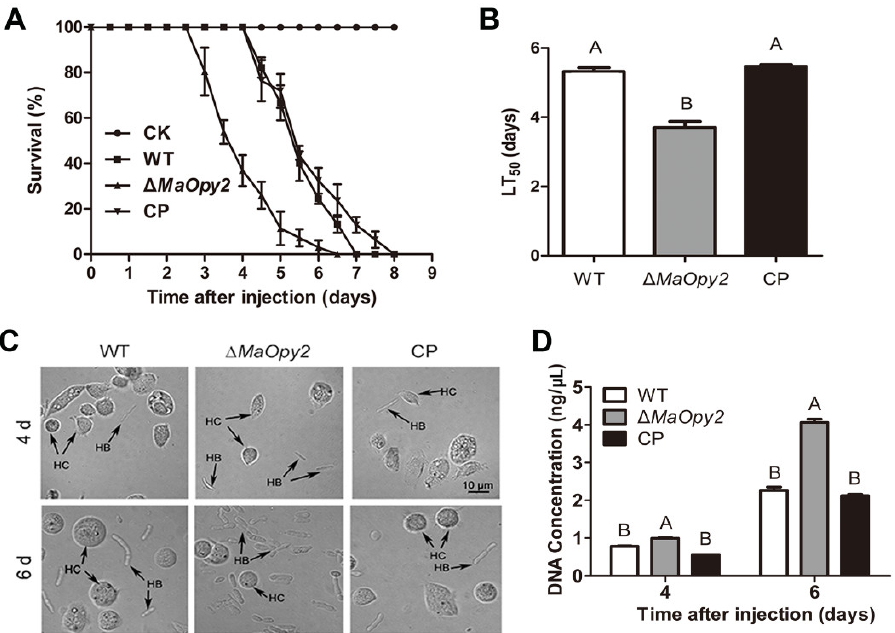
Figure 6. Injection assays. ( A ) Survivals of locusts by injection. ( B ) LT 50 s of fungal strains for injection. ( C ) Fungal growth inside insect hemolymph by injection inoculation for 4 d or 6 d. ( D ) Quantification of fungal strains in locust hemolymph. A & B presented the significant difference at p < 0.01.